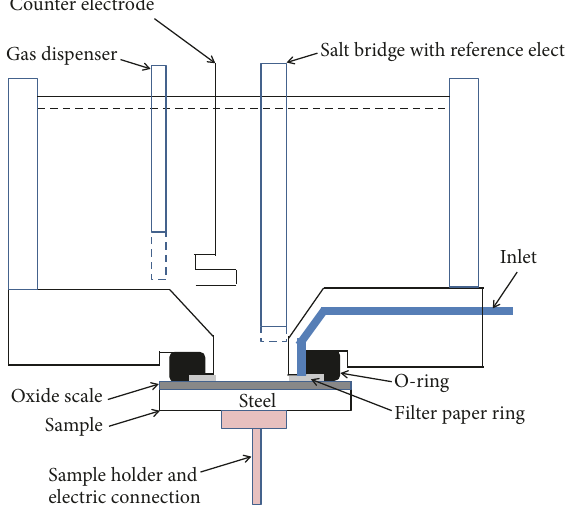
Figure 1: A schematic figure of the Avesta